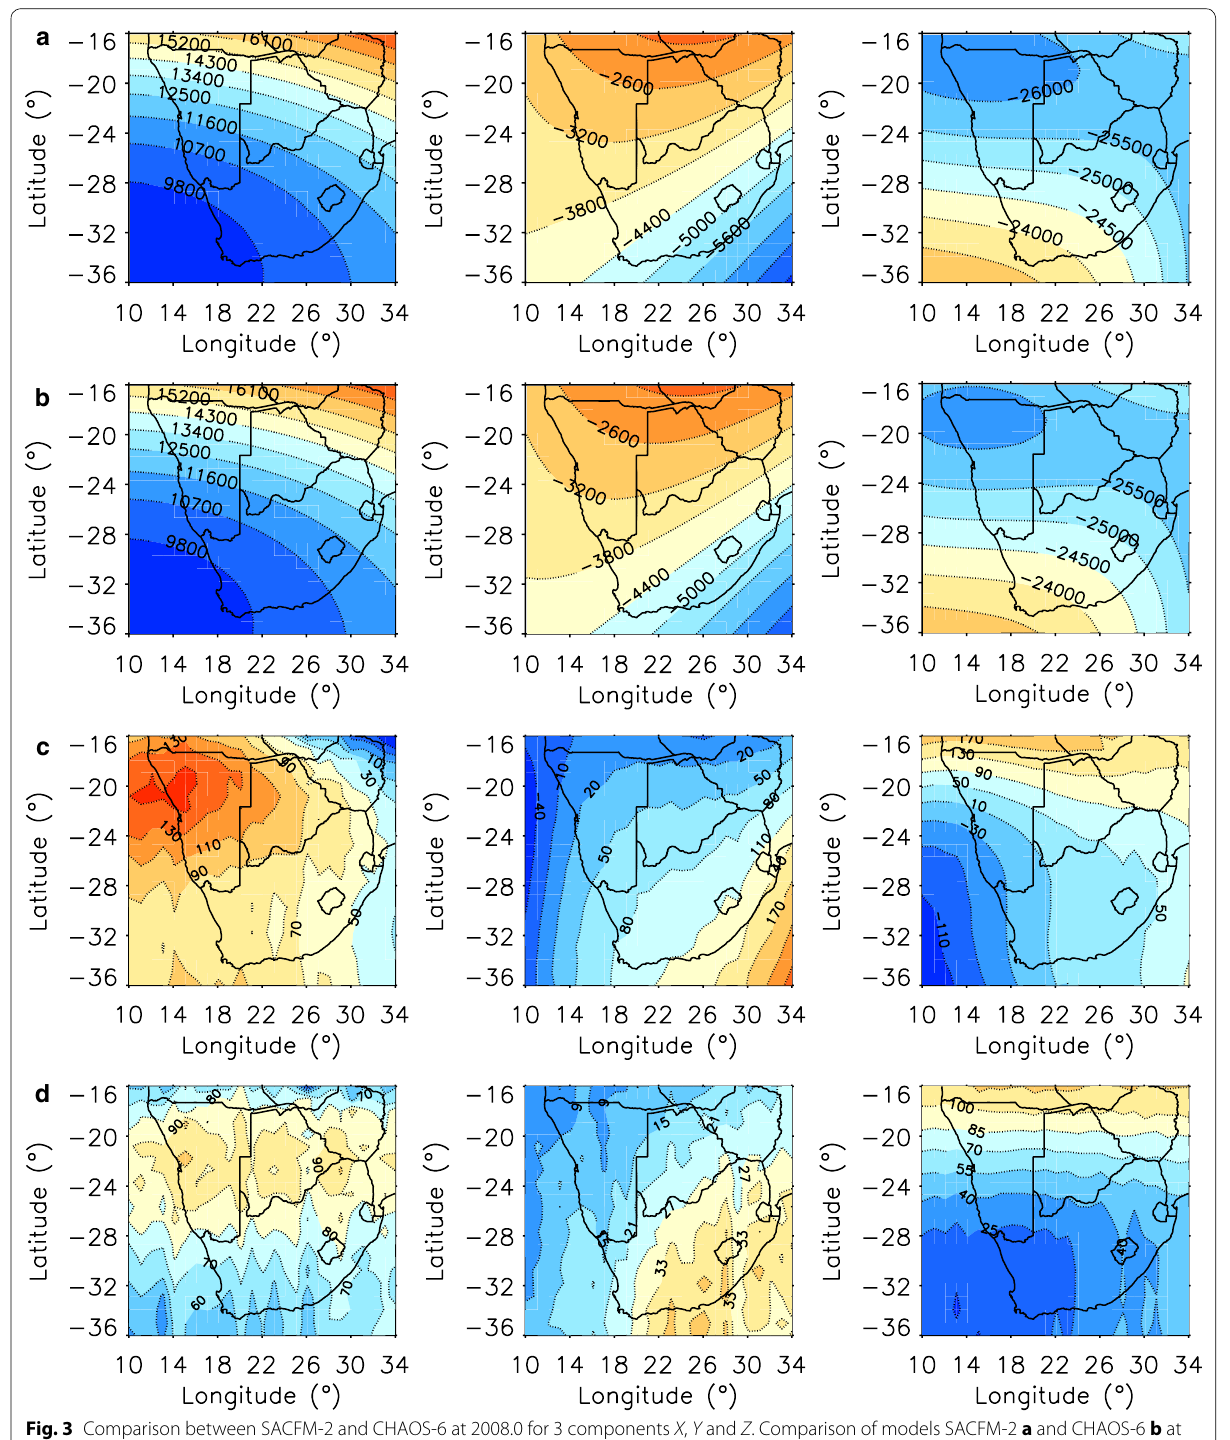
Fig. 3 Comparison between SACFM-2 and CHAOS-6 at 2008.0 for 3 components X , Y and Z . Comparison of models SACFM-2 a and CHAOS-6 b at epoch 2008.0, their differences are shown in the third row c and last row d at 0.8 and 350 km altitudes, respectively. The three components X , Y and Z are plotted in the first, second and third columns, respectively. The unit is